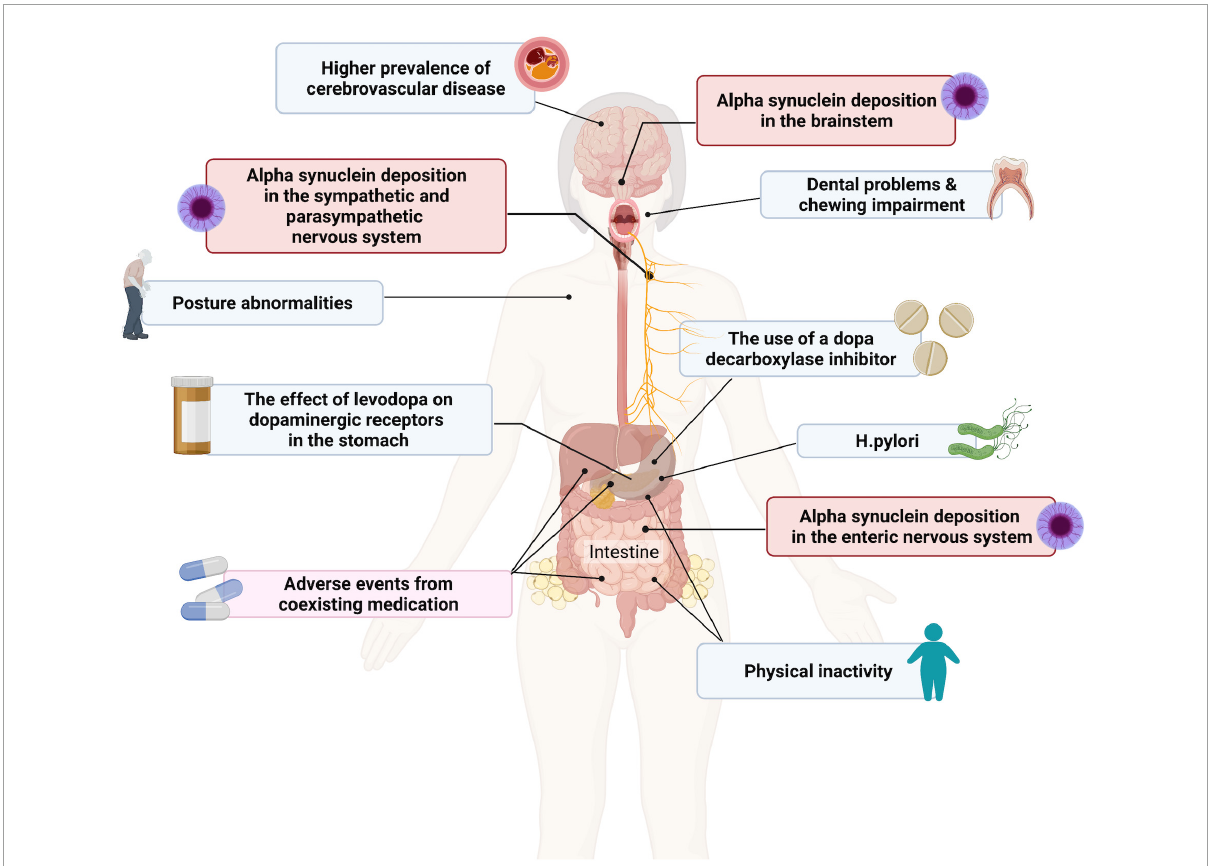
FIGURE1 Contributing factors to dysphagia and gastroparesis in patients with Parkinson’s disease (PD). Created with